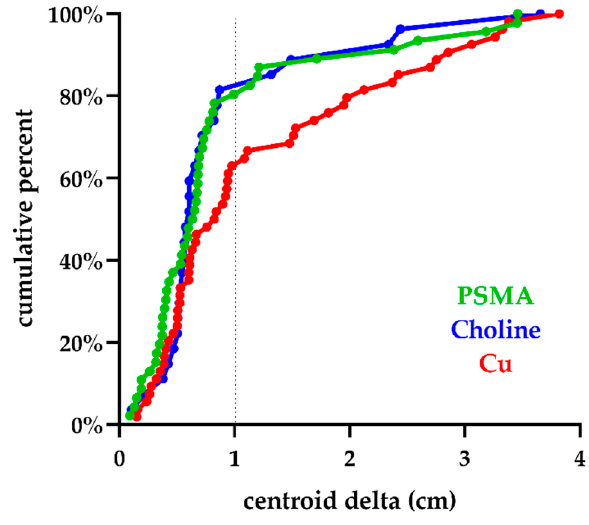
Figure 2. Cumulative frequency of minimum centroid distance for each tracer.